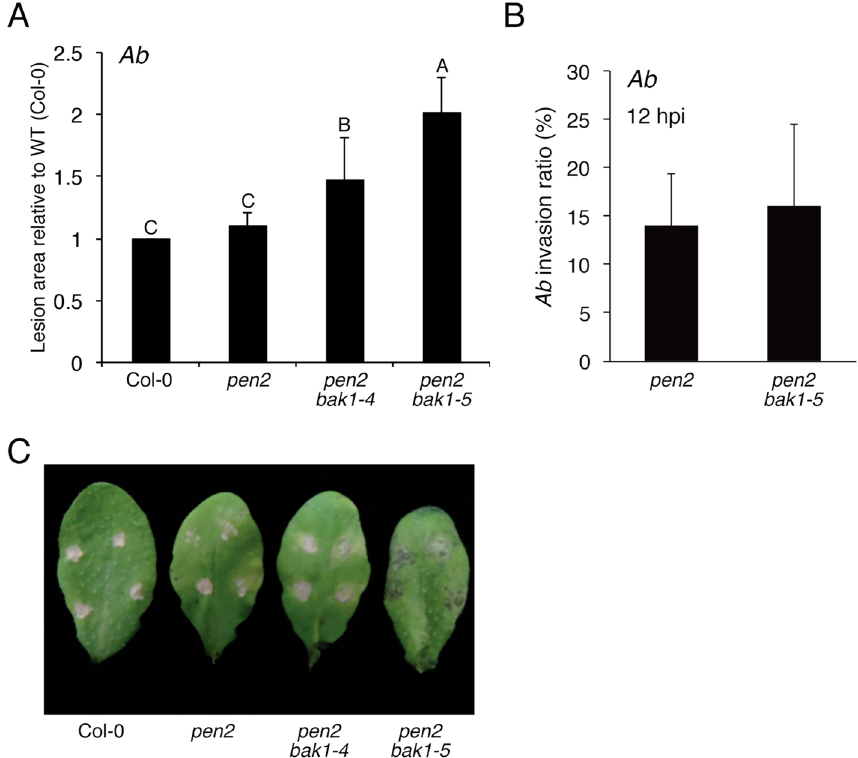
Figure 4. The bak1 mutations reduced the immunity of Arabidopsis against Ab . ( A ) Quantification of lesion development. Conidial suspensions of Ab (1 × 10 5 conidia/mL) were drop-inoculated onto true leaves of 4–5-week-old plants. At 4 dpi, lesion areas were measured and the relative values to Col-0 (WT plants) were calculated. The means and SDs were calculated from three independent experiments. The statistical significance of differences between means was determined by Tukey’s HSD test. Means not sharing the same letter are significantly different ( P < 0.05). ( B ) The bak1–5 mutation did not reduce preinvasive resistance against Ab in the pen2 mutant. Aliquots of 5 μL of conidial suspension (1 × 10 5 conidia/mL) of Ab were drop-inoculated onto leaves of 4–5-week-old plants of the tested mutants. At 12 hpi, the inoculated leaves were collected and stained with trypan blue, and then invasive hyphae were observed under light microscopy. At least 50 germinating conidia were counted in each experiment. The means and SDs were calculated from three independent experiments. Statistical analysis using two-tailed Student’s t tests showed no significant differences between pen2 and pen2 bak1–5 mutants. ( C ) Lesion development caused by Ab on two pen2 bak1 mutants. Conidial suspensions (1 × 10 5 conidia/mL) of Ab were drop-inoculated onto mature leaves of 4–5-week-old plants. The photograph was taken at 4